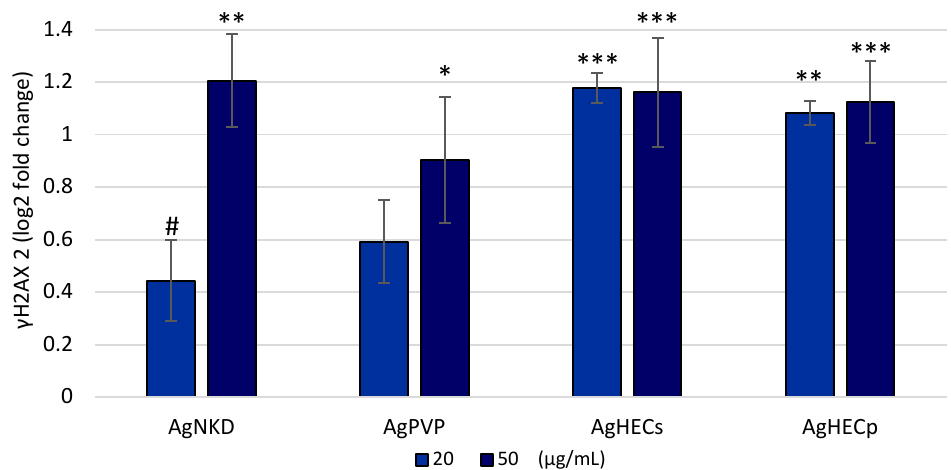
Figure 7. DNA damage (expressed as log2 FC of γ H2AX) was determined by quantifying the increase in the γ H2AX protein. Control values are equivalent to the zero line, values above this value are actual increases in the protein content while negative values are downregulation of the protein. Increases in DNA damages in exposed cells were observed for all the Ag NPs at the concentration of 20 and 50 µ g/mL. Data are presented as the mean of at least three independent experiments ± SE. Statistical difference analyzed by one-way ANOVA and Dunnett’s test. * p < 0.05 compared to control; ** p < 0.01 compared to control, ANOVA with post hoc; *** p < 0.001 compared to control, ANOVA with post hoc; # p < 0.05 compared to the 50 µ g/mL exposure concentration.